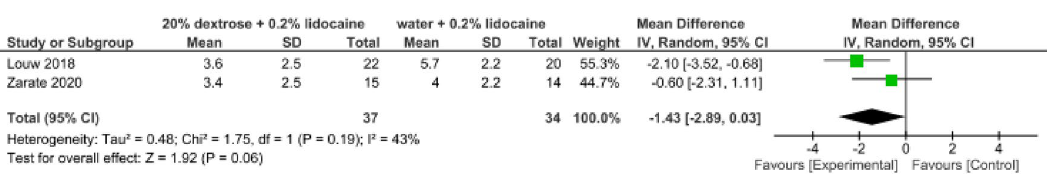
Figure 3. Dextrose versus Placebo injections for temporomandibular joint disability at 12